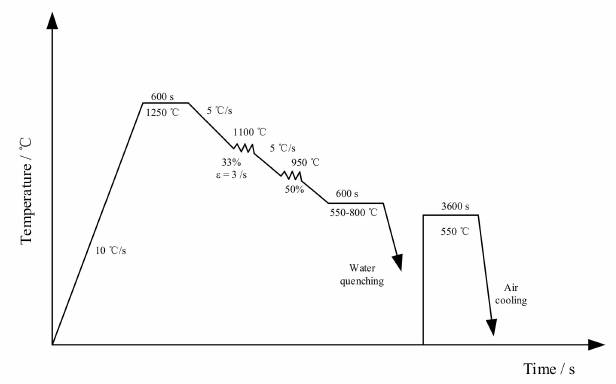
Figure 3. Schematic illustrations describing the thermal simulation.